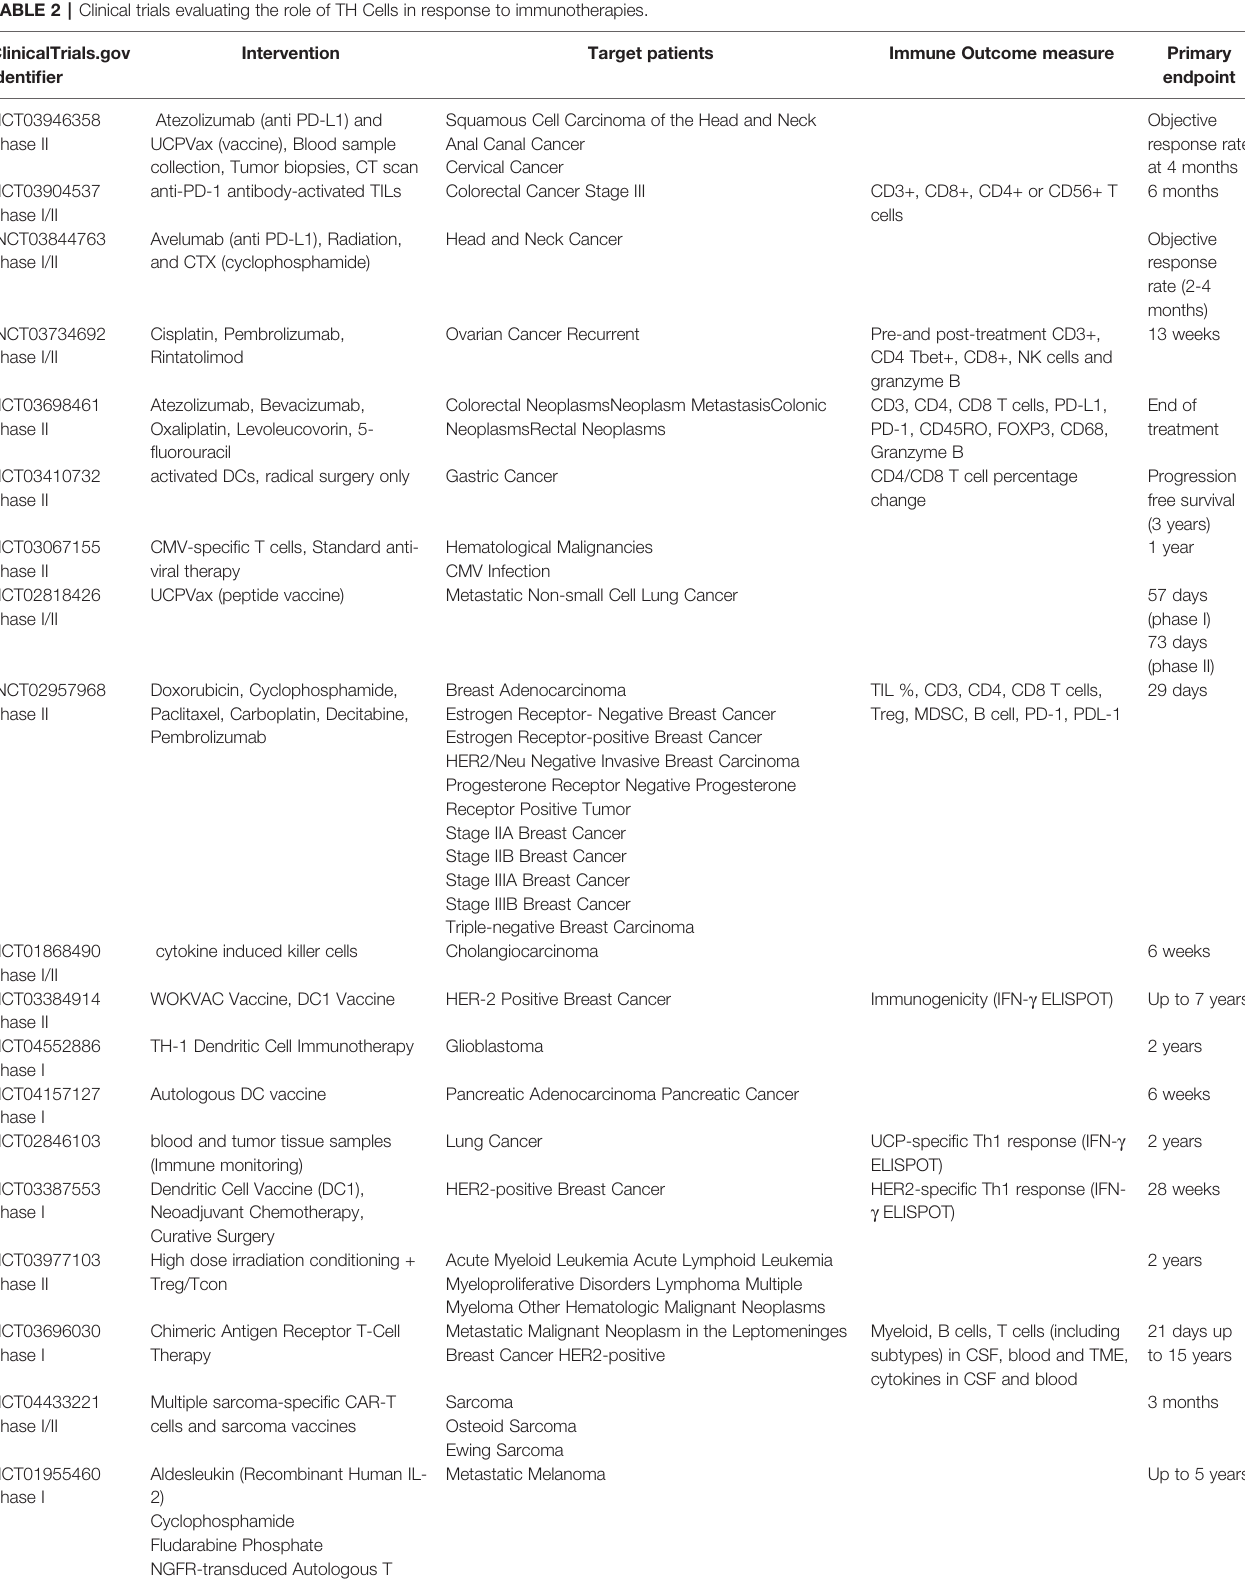
TABLE 2 | Clinical trials evaluating the role of TH Cells in response to immunotherapies. ClinicalTrials.gov Identi fi